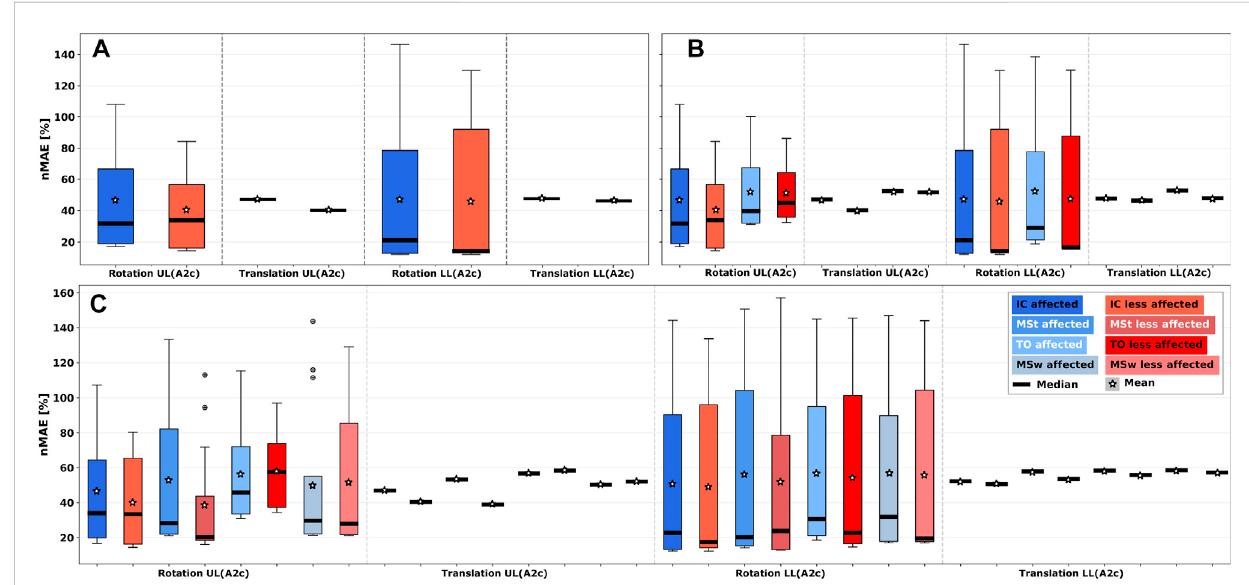
FIGURE 9 Sensor repositioning error analysis considering rotatory and translatory errors parts for Algo. A2c in all gait phase models. (A) 1-phase model. (B) 2- phase model. (C) 4-phase model. UL: Upper leg; LL: Lower leg. Larger IQRs for rotatory errors can be observed comparedto translatory errors, as well as larger error IQRs in the 4-phase model compared to 1- and 2-phase